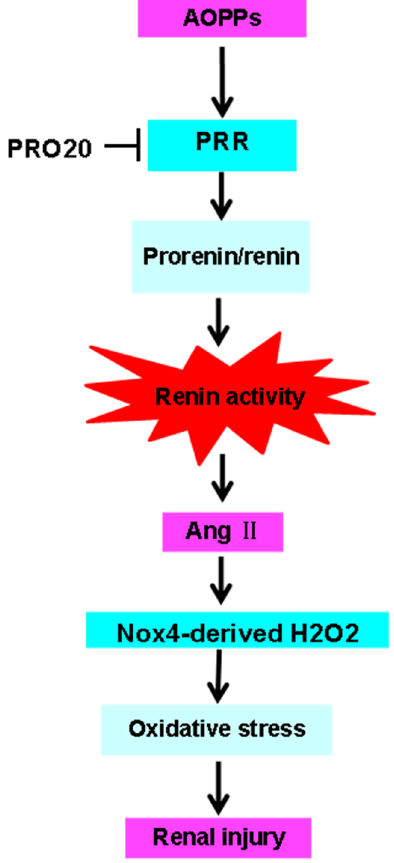
Figure 7. Diagram illustrating the action mechanism of AOPPs-RSA. AOPPs-RSA induces activation of the RAS, which leads to higher renin activity and Ang II release that activates Nox4-dependent H 2 O 2 production and eventually results in renal injury. This process was abolished by PRO20. Abbreviations: AOPPs, advanced oxidative protein products; PRR, renin/prorenin receptor; Ang II, angiotensin II; Nox4, NADPH oxidase 4; H 2 O 2 , hydrogen peroxide.